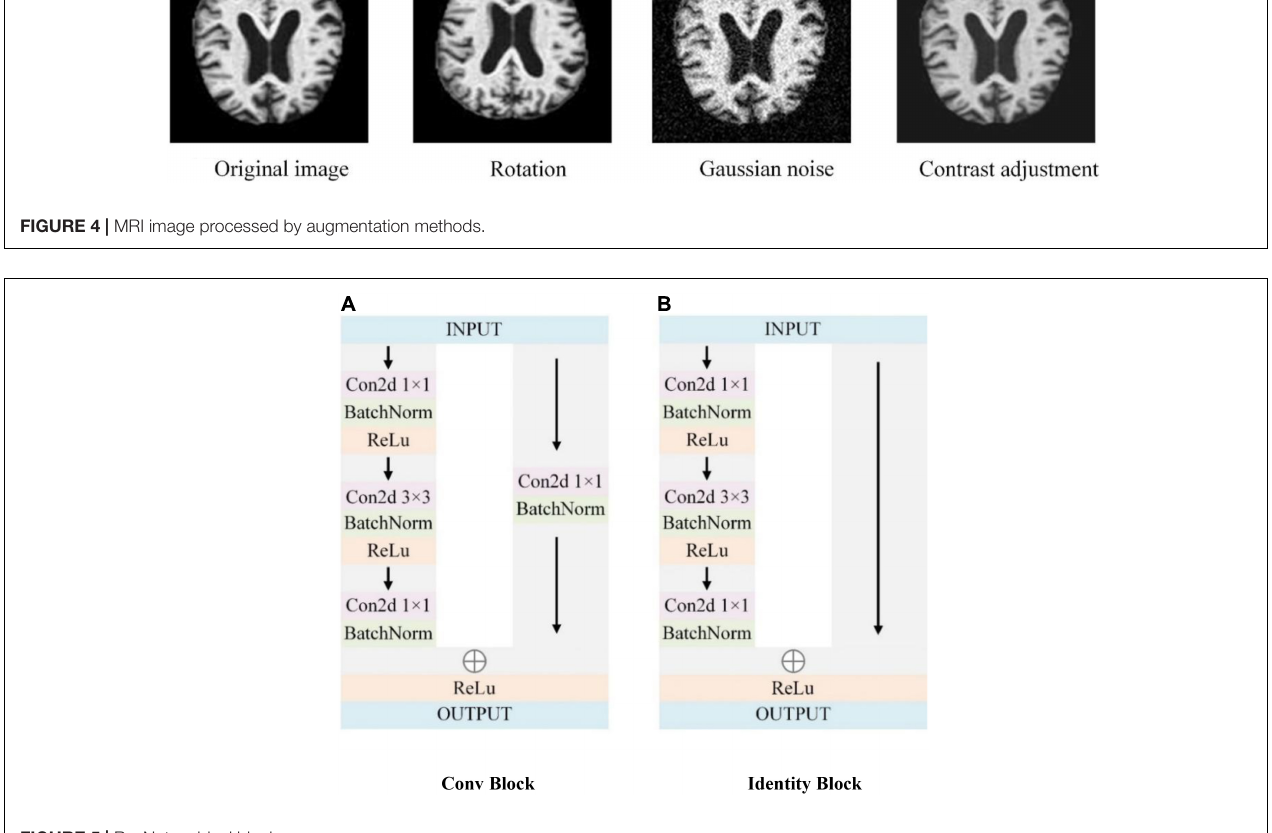
FIGURE 5 | ResNet residual